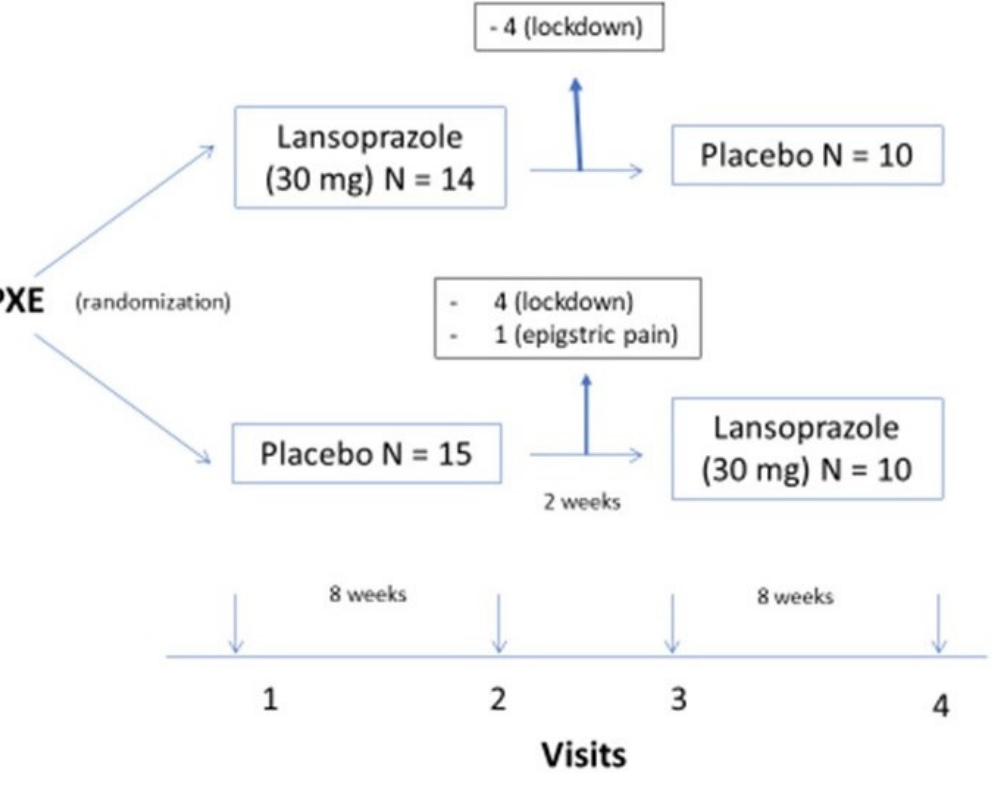
Figure 1. legend: design of the trial. Table 1. Clinical characteristics of